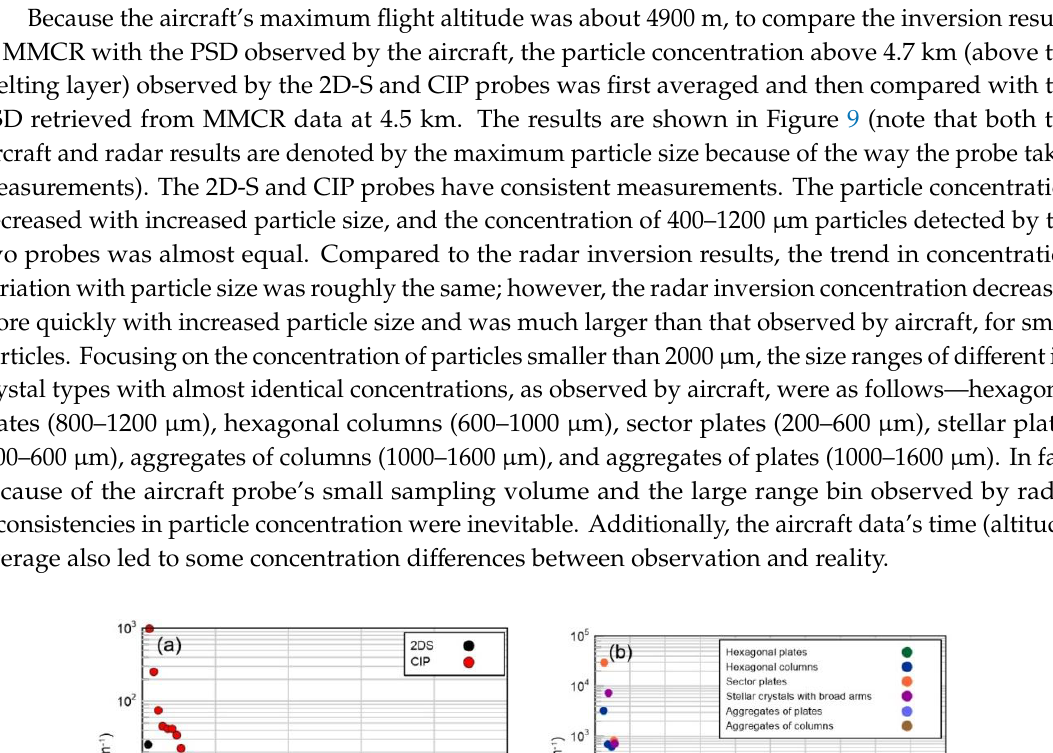
Figure 8. Mean volume-weighted diameter and IWC of different ice crystals retrieved from radar data—hexagonal plates ( a ), hexagonal columns ( b ), sector plates ( c ), stellar plates with broad arms ( d ), aggregates of plates ( e ), and aggregates of columns ( f ).